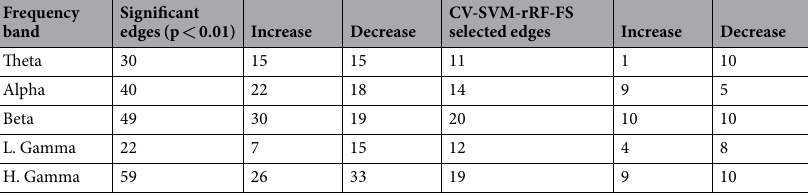
Table 1. Univariate analysis and CV-SVM-rRF-FS results summary.